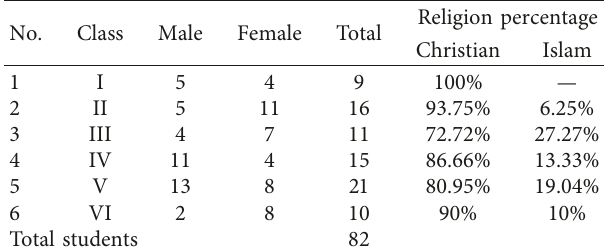
Table 3: Percentage of total students at Kawangkoan Presidential- Instruction Elementary School, North Minahasa,